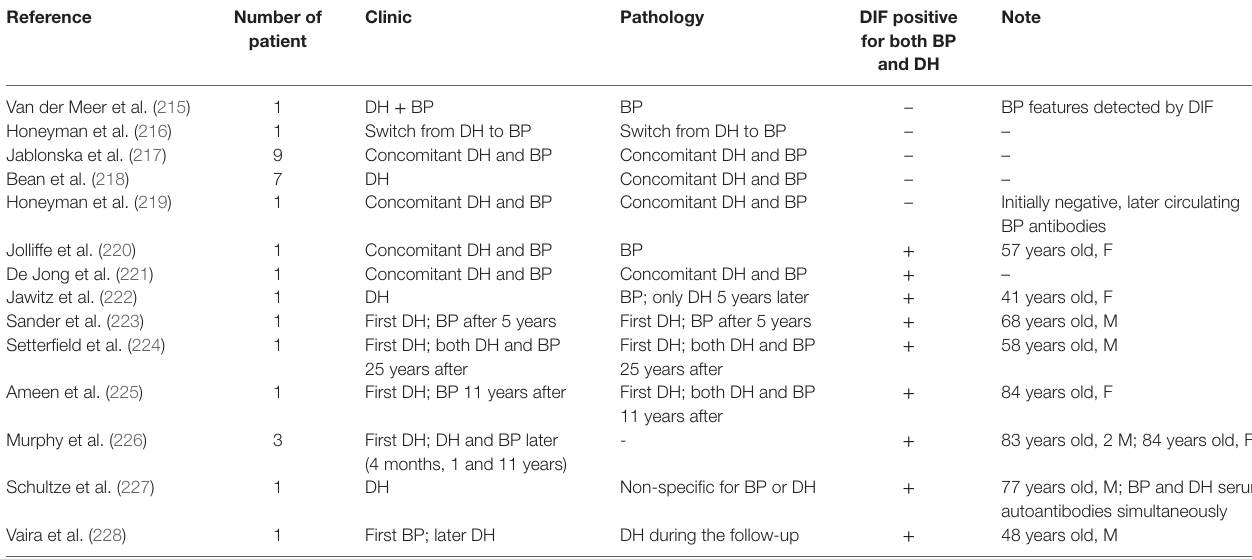
TABLe 6 | Patients with a history of DH and